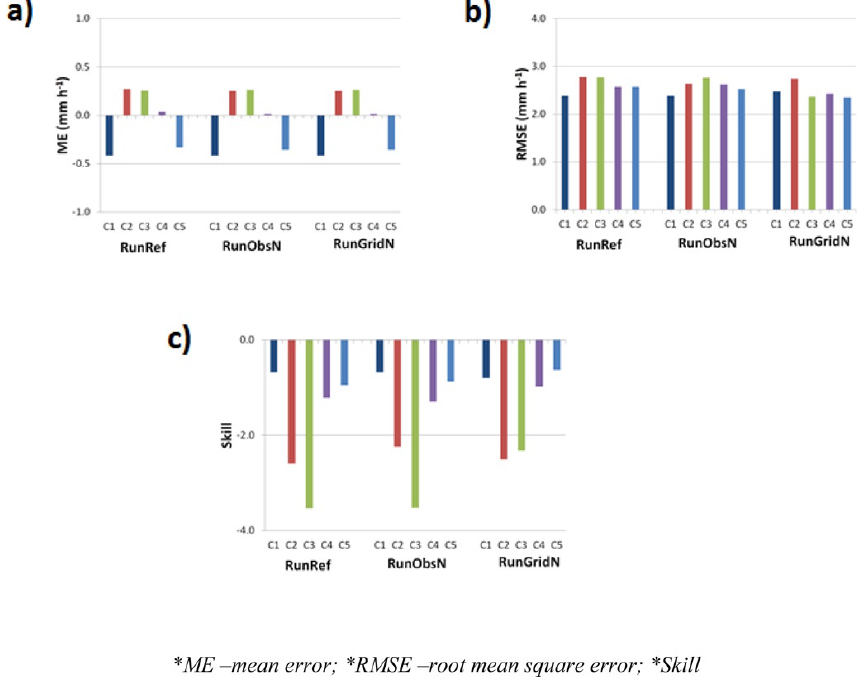
Fig. 8. Continuous verification measurements of the hourly precipitation (above 0.1mmh − 1 ) for the stations grouped by altitude class.